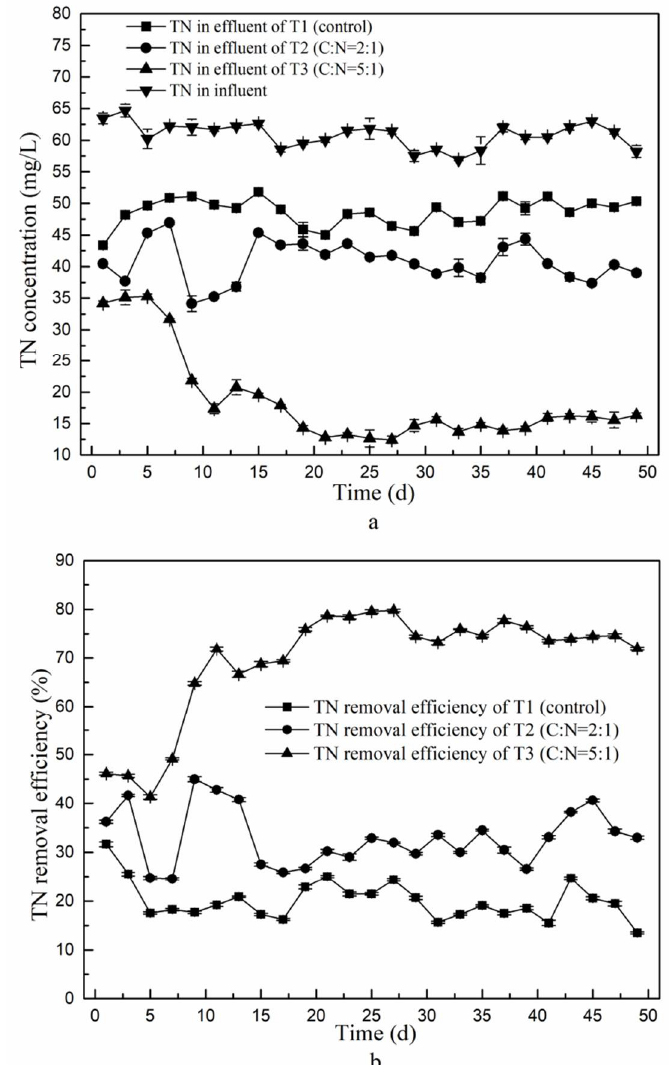
Figure 5. Total nitrogen removal of the second stage of the CRI of the three experimental tests with variable C/N ratios. ( a ) Total nitrogen concentration in influent of the first stage and in effluent of the second stage; ( b ) Total nitrogen removal efficiency.